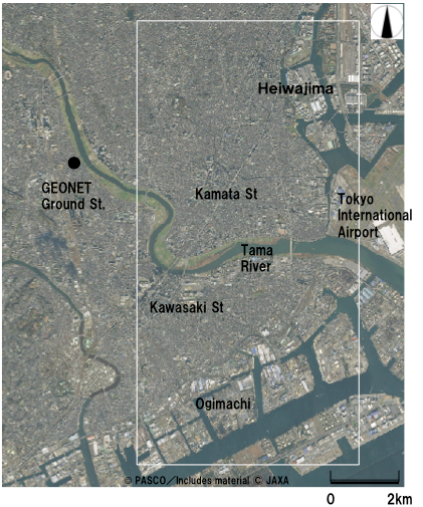
Figure 1. Study area in Tokyo Ota-ku and Kawasaki-shi. White frame shows the analysed area. GEONET ground station is about several kilometers west of study area